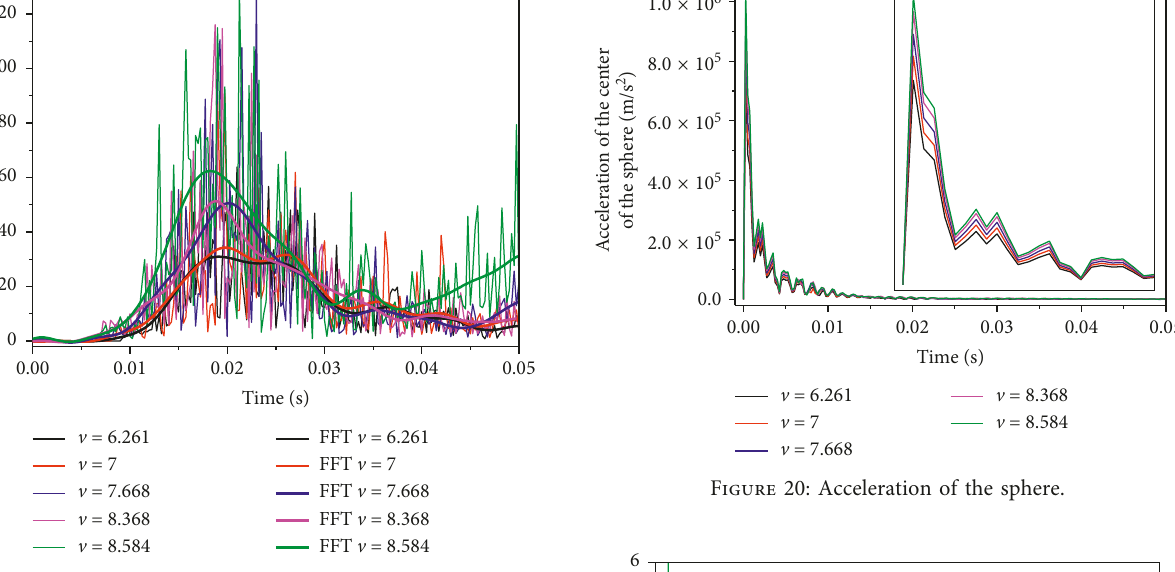
Figure 18: Acceleration of the tail beam.